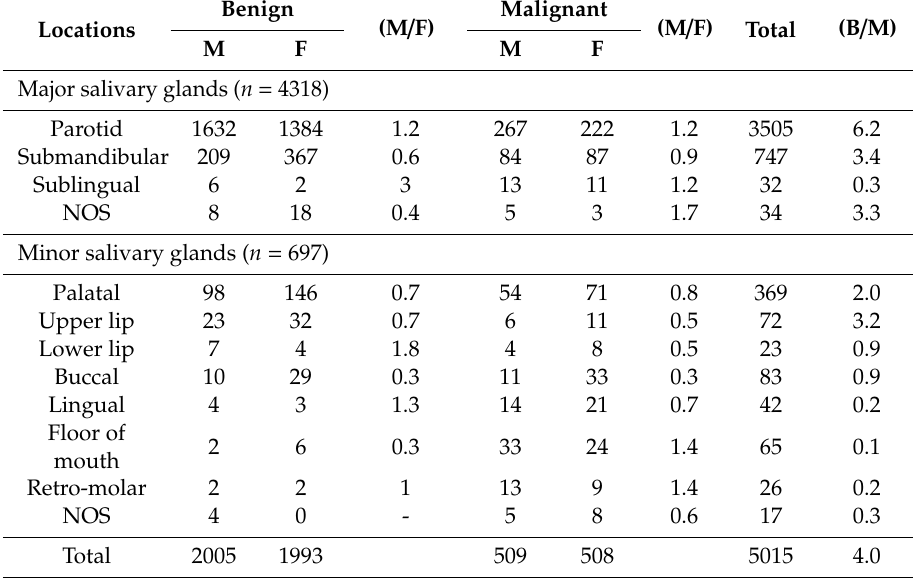
Table 2. Locations and sex distribution in 5015 salivary gland tumors.